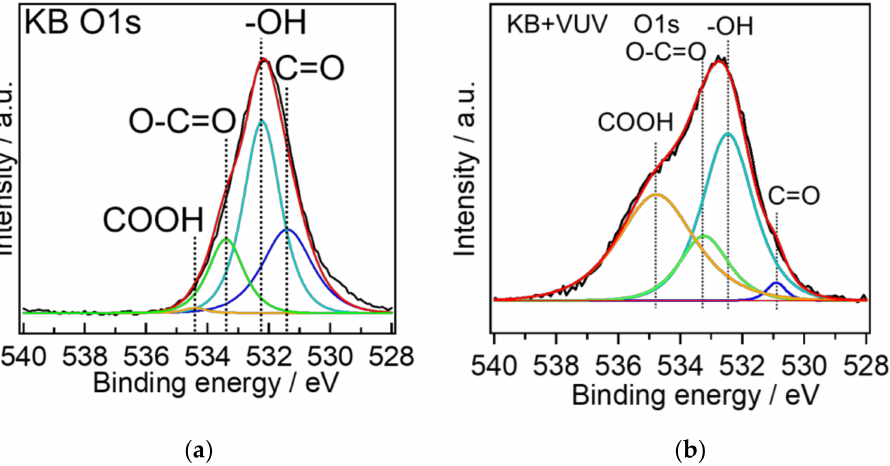
Figure 2. XPS O 1s spectra of ( a ) KB and ( b ) KB + VUV samples. Light green, light blue, blue, orange, and red lines show O-C=O, -OH, C=O, -COOH bonds, and overall fitting, respectively.